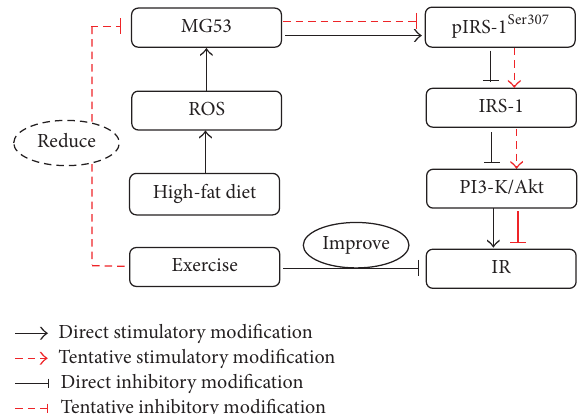
Figure 1: The signaling pathway of high-fat diet induced IR through TRIM72 and PI3-K/AKT in skeletal muscle. Whether the swimming exercise can improve insulin resistance in Sprague-Dawley rats fed with high-fat diet through inhibiting TRIM72 expression and activating PI3-K/AKT signal pathway should be further